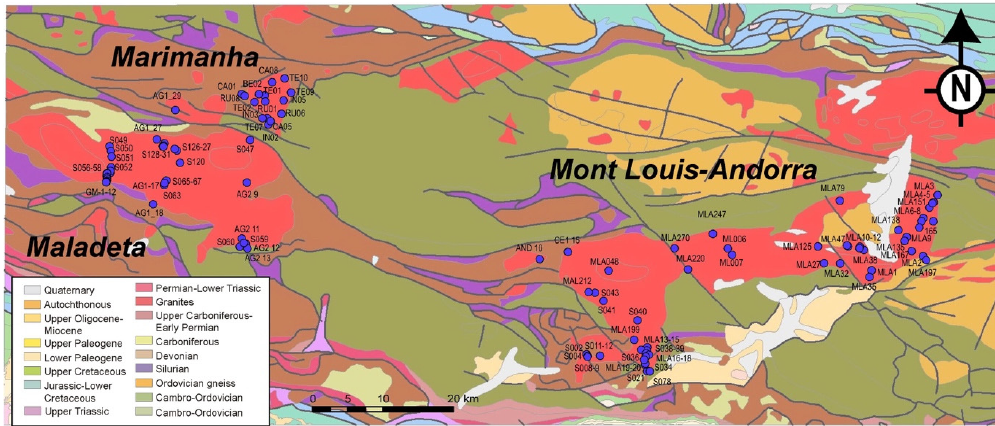
Figure 3. Location of the studied granitic sites in the Central Pyrenees. Geological map modified from Clariana et al. [109]).